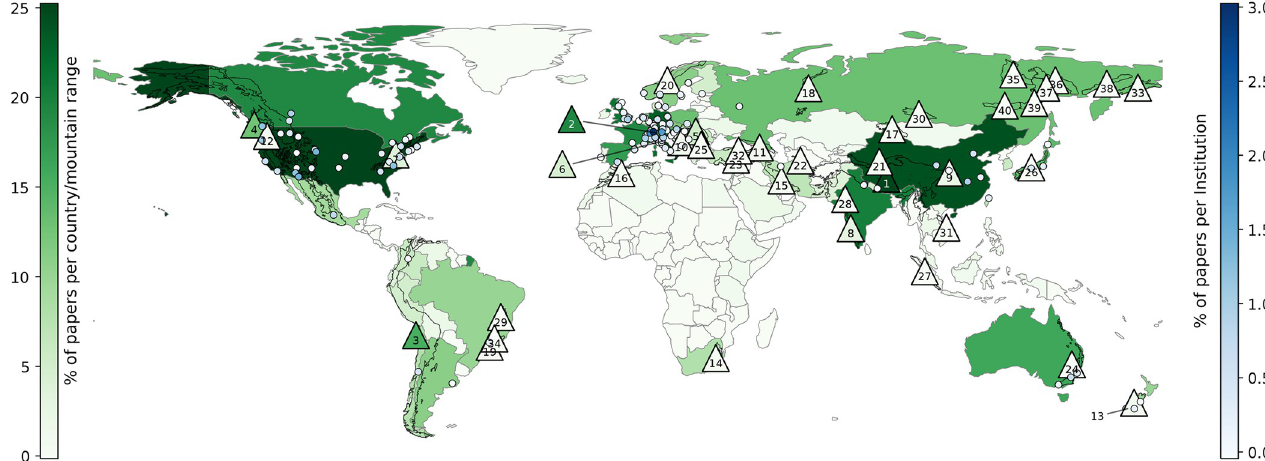
Fig 7. % of total papers per country (greens) and range (greens; triangles with numbers referring to mountain ranges in Table 2). % of total papers per university-like institution (blues; dots) for the top 200 university-like institutions. Polygons (black edge-color) indicate the considered mountain ranges (see methods and discussion for details). Background image made with Natural